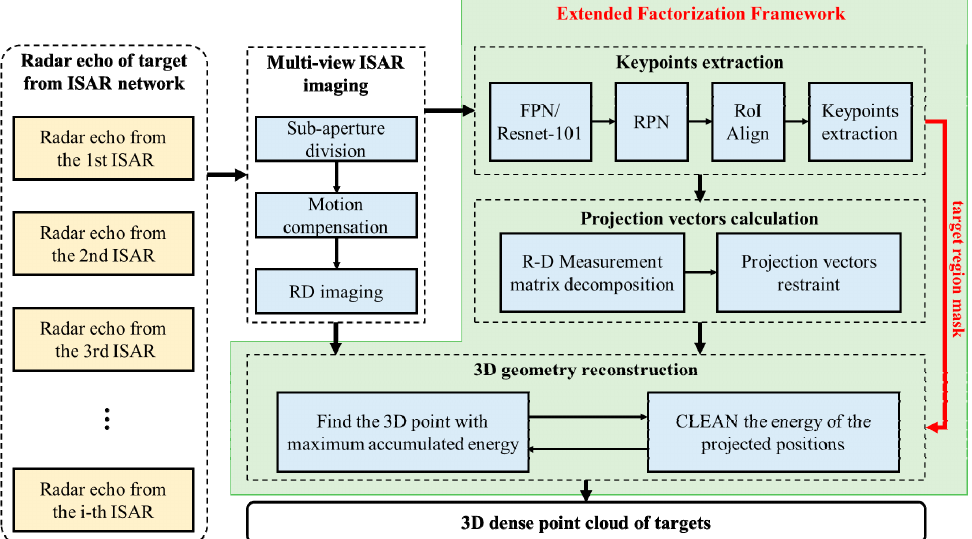
Figure 4. Flowchart of the proposed method.